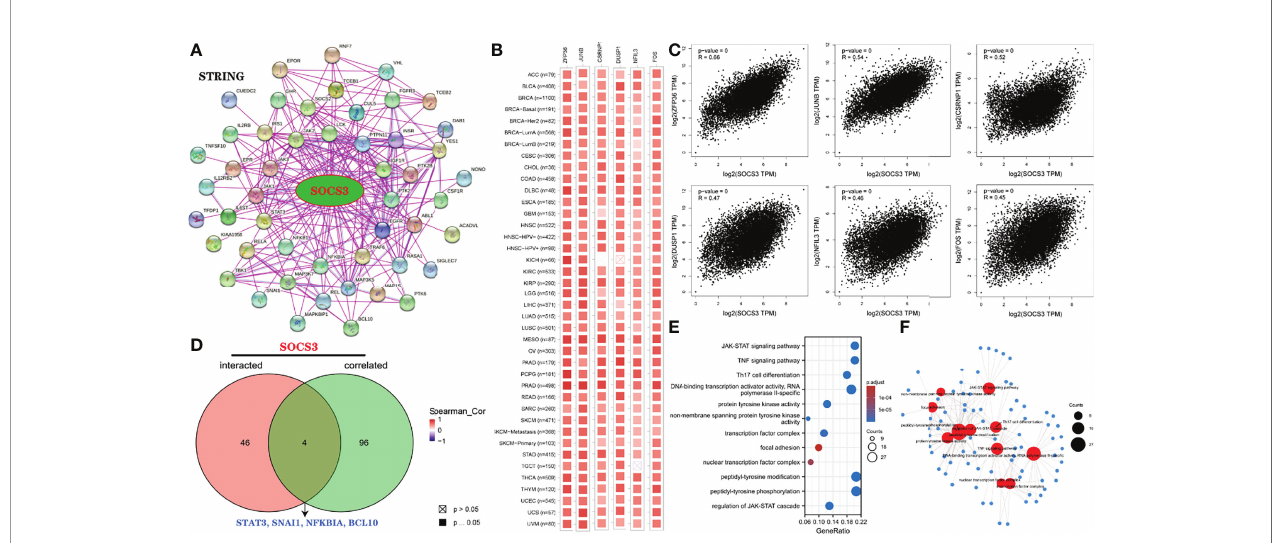
FIGURE 10 | Enrichment analysis of SOCS3 -related genes. (A) SOCS3 -binding proteins via STRING dataset. (B, C) One hundred genes related to SOCS3 were obtained via GEPIA2 database, and 6 genes most related to SOCS3 were speci fi cally analyzed, including ZFP36, JUNB, CSRNP1, DUSP1, NFIL3 , and FOS . Then, the heatmap corresponding to these genes were analyzed in detail. (D) Intersection genes of SOCS3 -binding and correlated genes. (E, F) GO and KEGG analysis based on SOCS3 -binding genes and interacted genes.